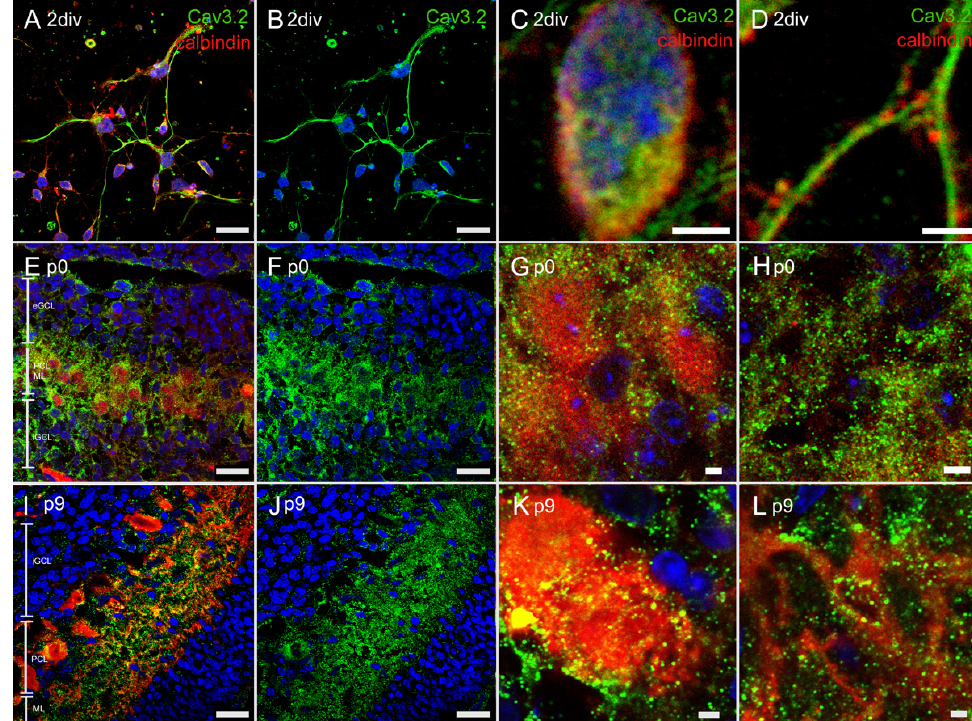
Figure 4. In vivo and in vitro expression of Cav3.1: Immunostaining of Cav3.1, in dissociated PCs at 2div ( A – D ) and cryosections of rat cerebella at p0 ( E – H ) and p9 ( I – L ). Cav3.1 (green), calbindin (red) and nuclear staining with Hoechst (blue). The cryosections showed the physiological layers of the cerebellum, namely, the external granular cell layer (eGCL), the molecular layer (ML), the PC layer (PCL), and the internal granular cell layer (iGCL). The in vitro PCs grown in serum-free medium developed dendrites or axons, with a clear Cav3.1 signal. Scale bar: 20 µm ( A , B , E , F , I , J ) and 5 µm ( C , D , G , H , K , L ).